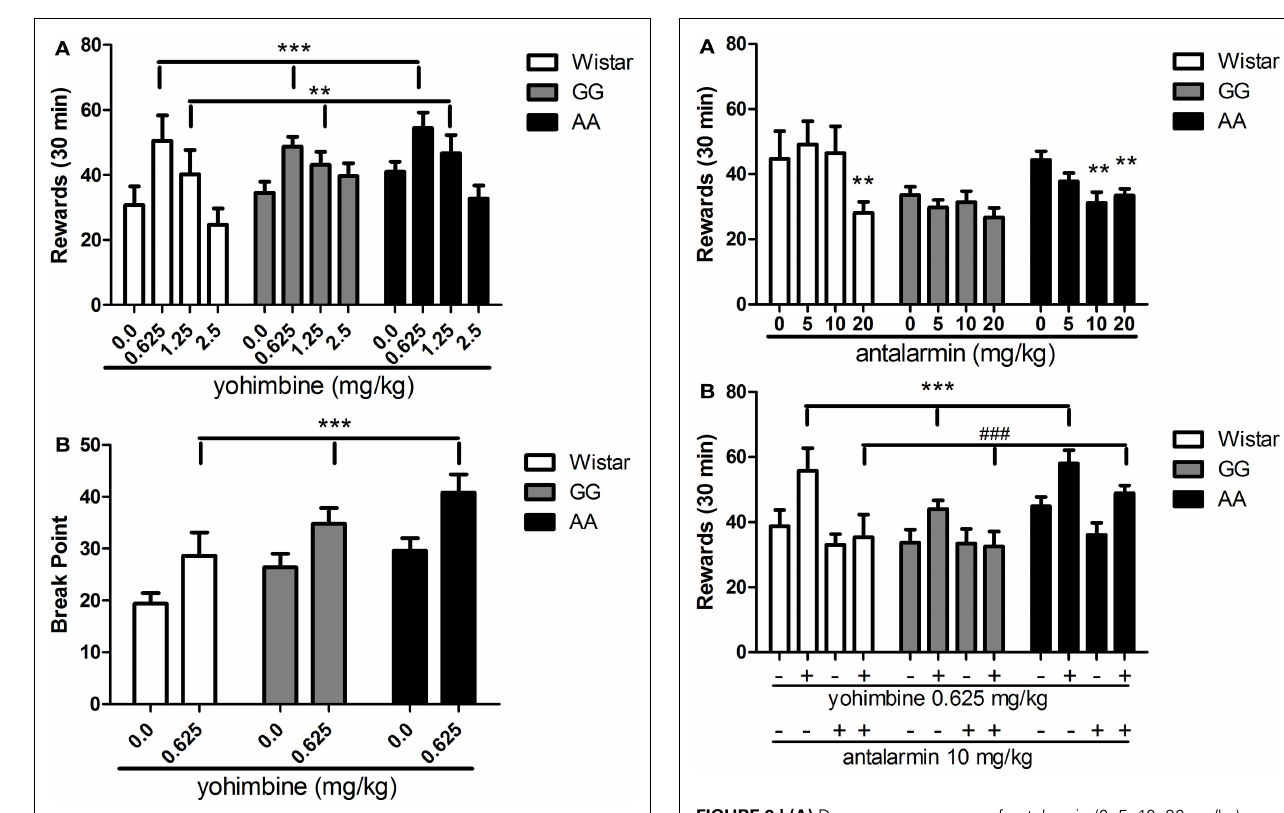
under FR-3 schedule. Overall ANOVA revealed a significant main effect of treatment [ F (3,90) = 7.1, p < 0.001], significant main effect of “line” [ F (2,30) = 4.5, p < 0.05] and significant